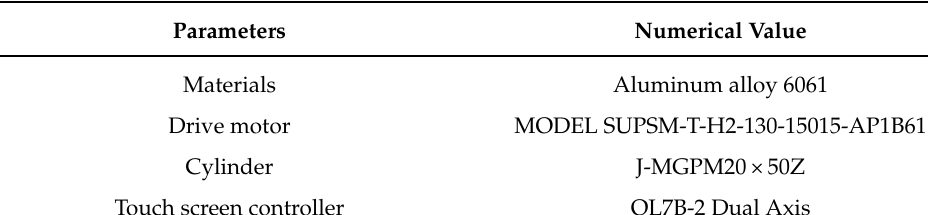
Table 10. Component selection of prototype.